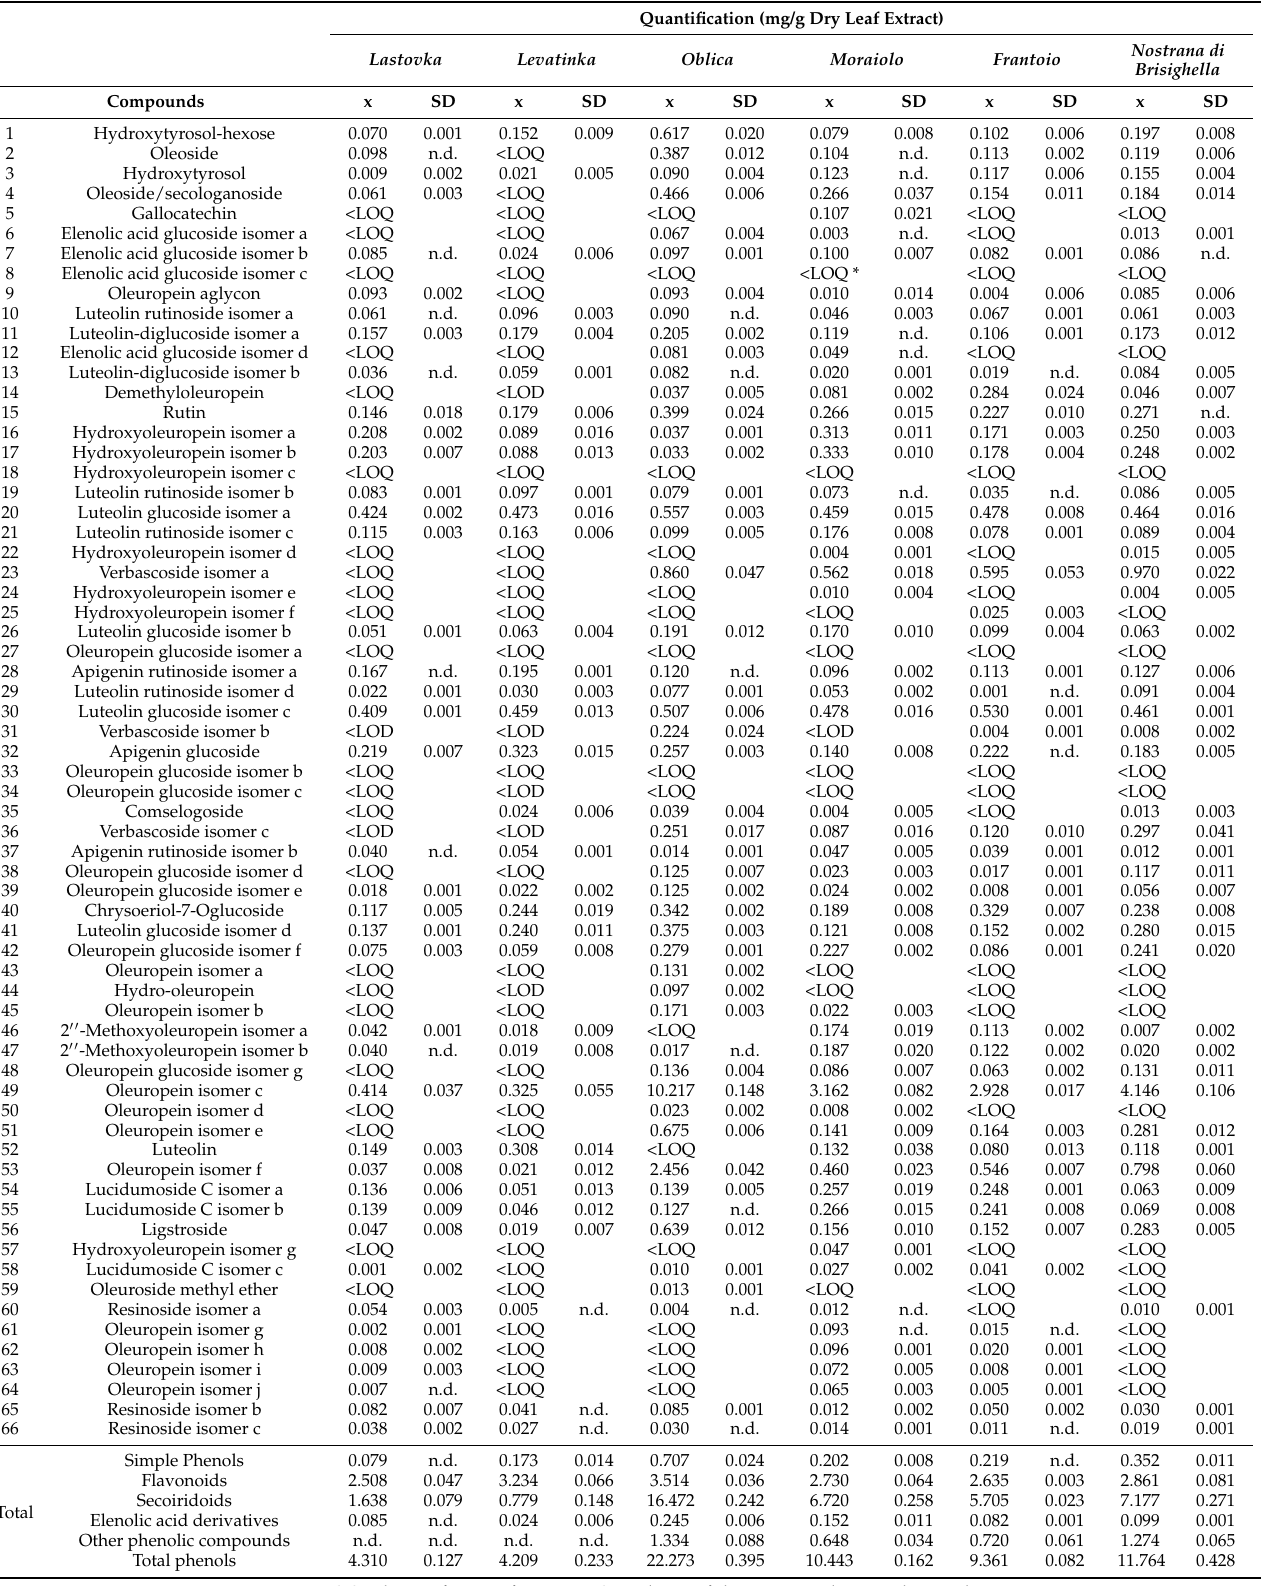
Table 1. Phenolic compounds in olive leaves determined by HPLC-PDA-ESI-QTOF-MS and expressed in mg analyte/g dry leaf